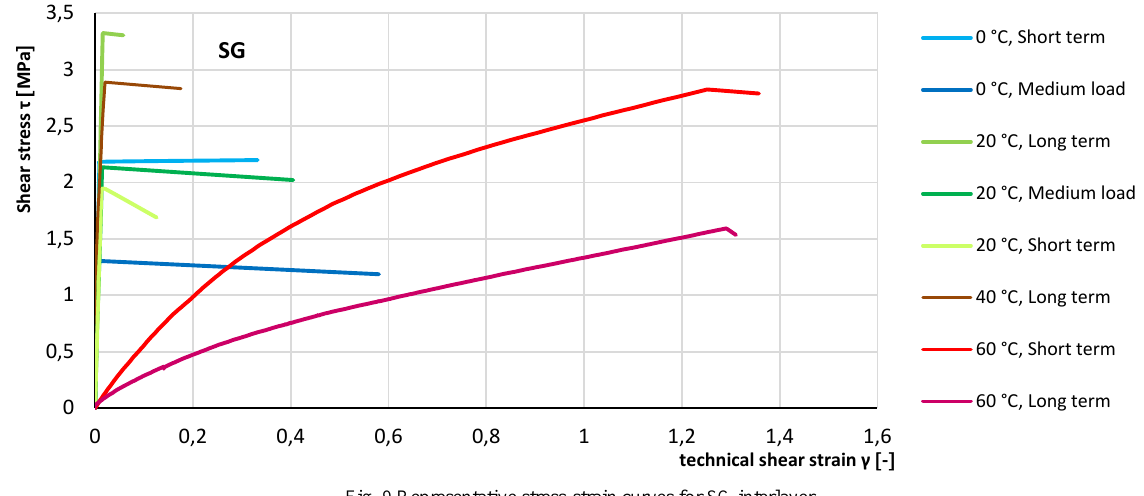
Fig. 9 Representative stress-strain curves for SG interlayer.